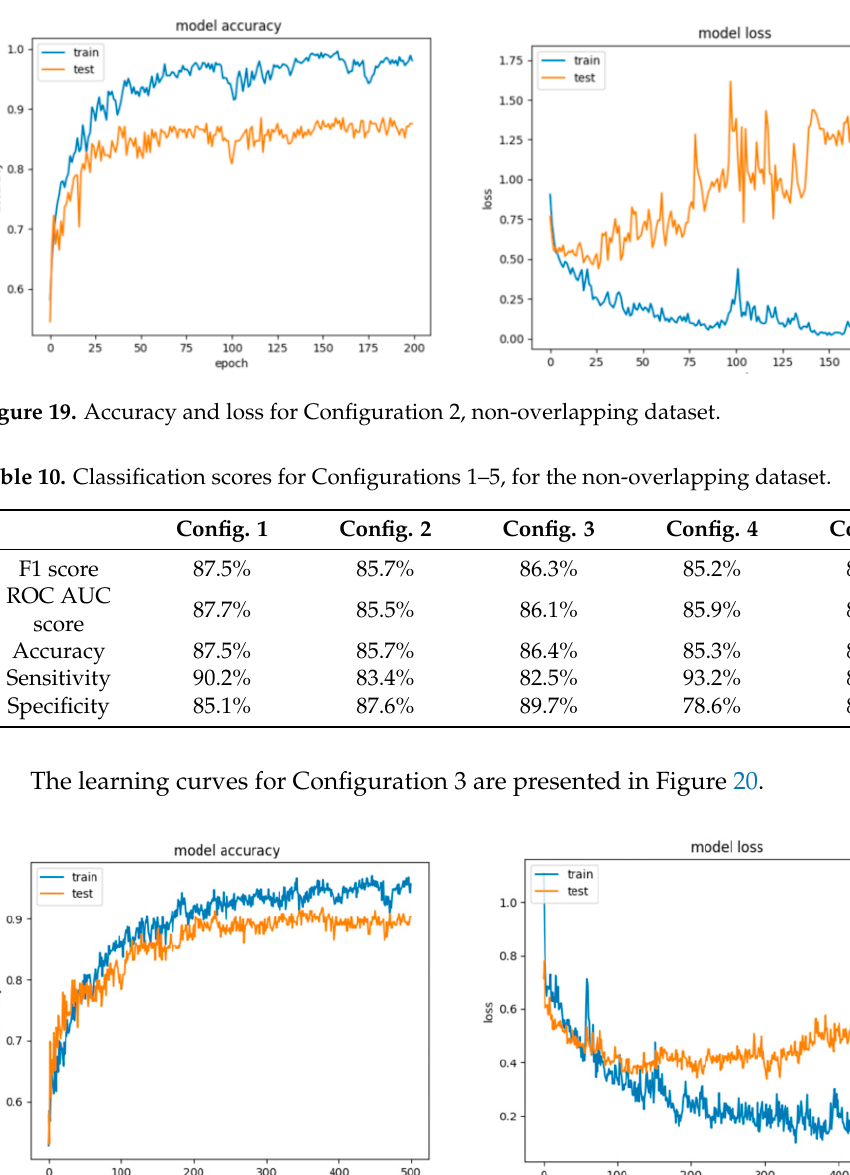
Figure 21. Accuracy and loss for Configuration 4, non-overlapping dataset. For Configuration 5, we considered changing the number of neurons on the hidden layer to 11, to match the formula presented in [51]. It can be observed that adding the extra layer did not help improve the performance (Table 10); however, the model still tended to overfit (Figure 22). We chose Configuration 3 to be the best model because it did not overfit and because it also obtained some of the best classification scores (ROC AUC score of 86.1%). The five- fold cross-validation (during 500 epochs with a batch size of 32, Adam Optimizer with a decaying learning rate) and the averaged scores for 10 runs for this model (70% training and 30% testing data) are presented in Table 11. Table 10. Classification scores for Configurations 1–5, for the non-overlapping dataset. Config. 1